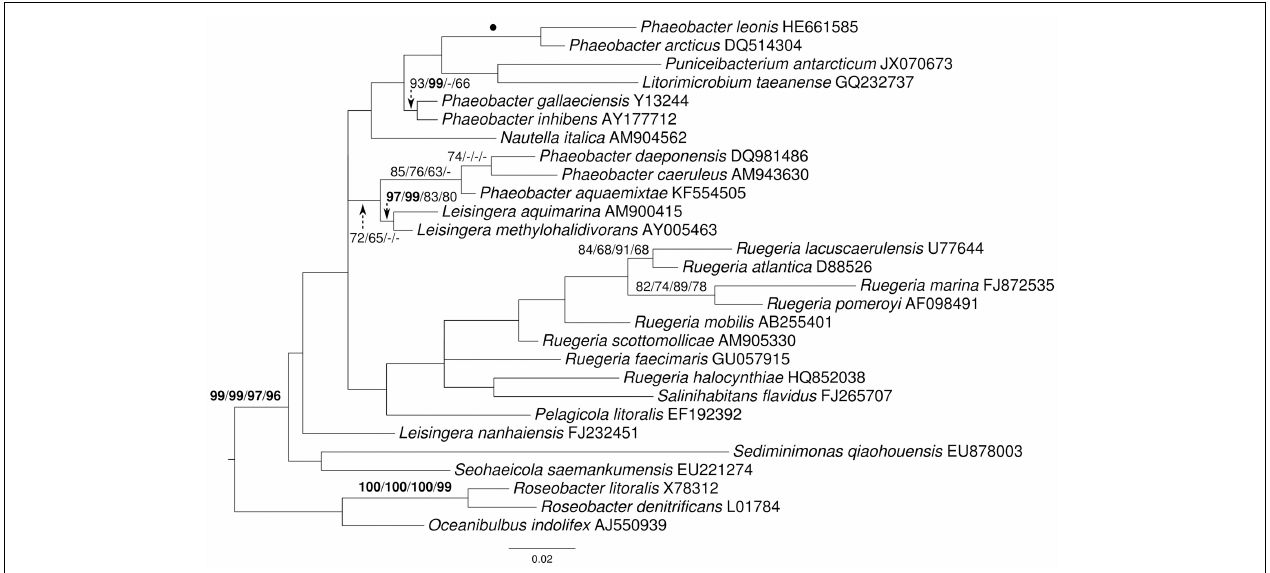
FIGURE 3 | Phylogeny inferred from the 16S rRNA gene matrix under the maximum likelihood (ML) criterion and the maximally supported branches of the topology depicted in Figure 1 as backbone constraint. Rooting was done with Oceanibulbus and Roseobacter . The branches are scaled in terms of the expected number of substitutions per site. Numbers